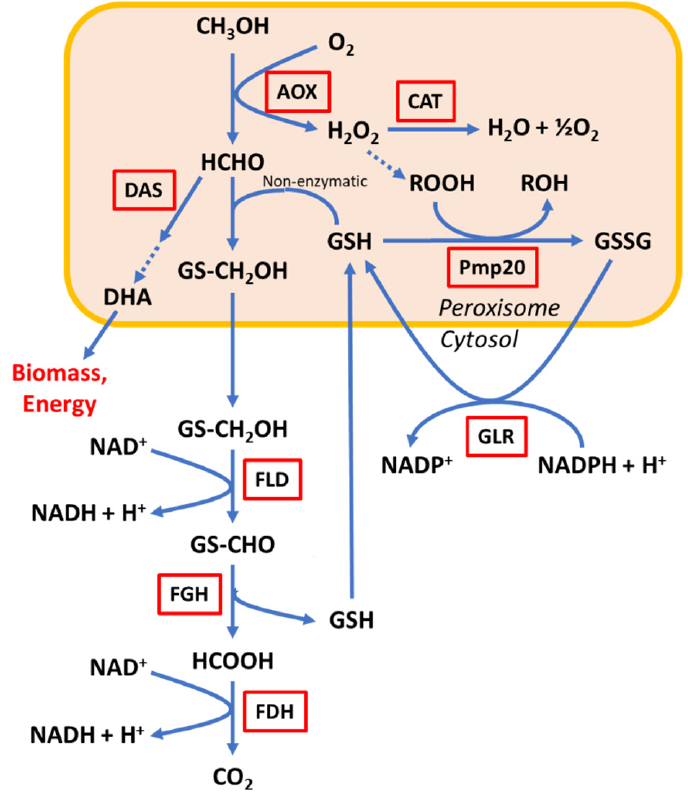
Figure 1. Main steps of the methanol utilisation (Mut) pathway in K. phaffii . Relevant enzymes involved are shown in red boxes. (Adapted from [10]). AOX: alcohol oxidase; CAT: catalase; DAS: dihydroxyacetone synthase; FLD: formaldehyde dehydrogenase; FGH: S-formylglutathione hydrolase; FDH; formate dehydrogenase; GS(H): glutathione; Pmp20: peroxisomal glutathione peroxidase; GLR: glutathione reductase.